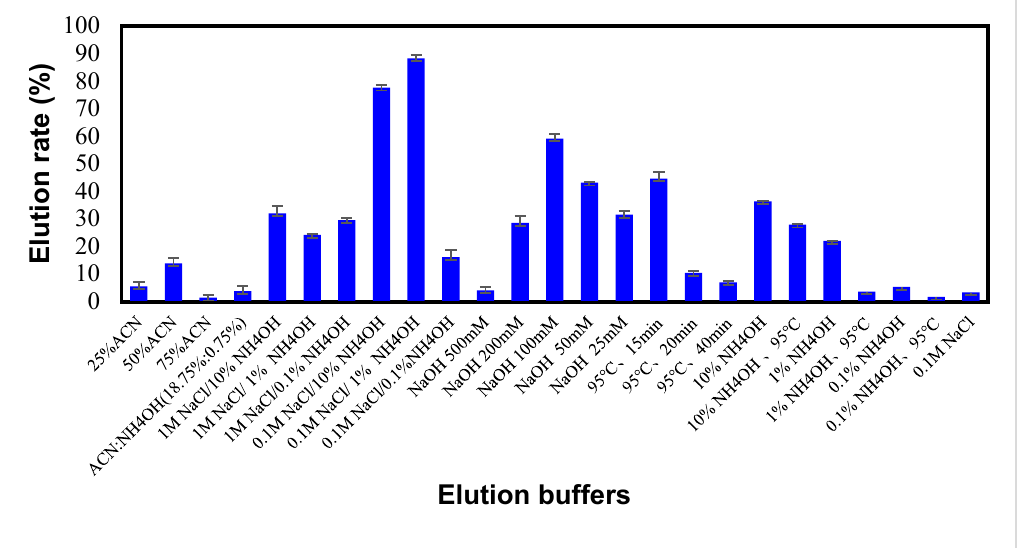
Figure 5. Elution rates of MRSA using different elution solvents.